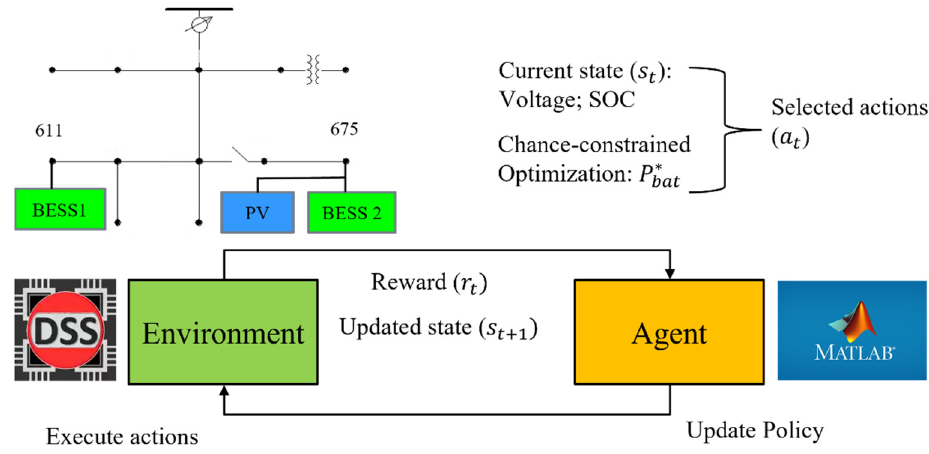
Figure 3. Proposed method implementation.